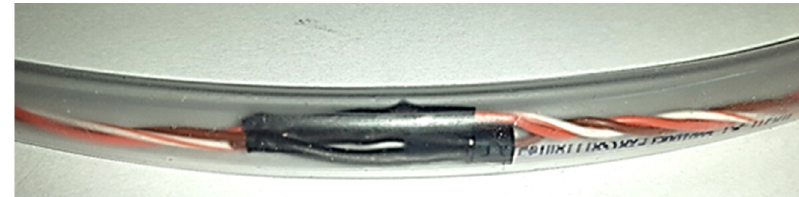
Figure 12. DS18B20 sensor on the 1-wire bus inside the protection hose.